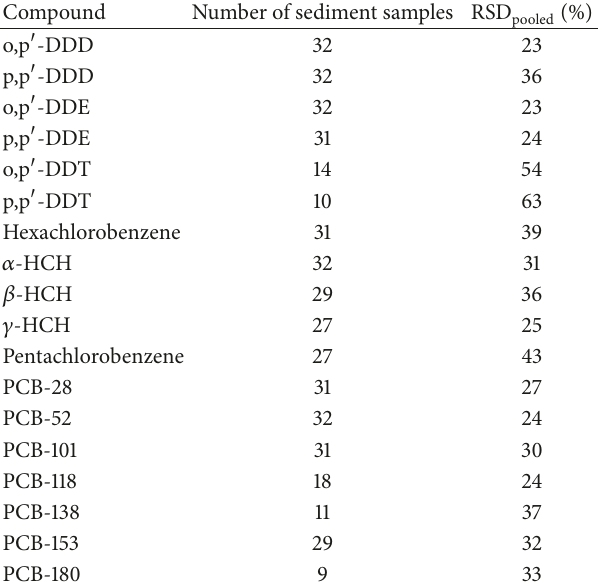
Table 7: Intermediate precision assessed by the analysis of different sediments collected in the area of study. The number of sediment samples corresponds to those of samples with mass fraction above detection